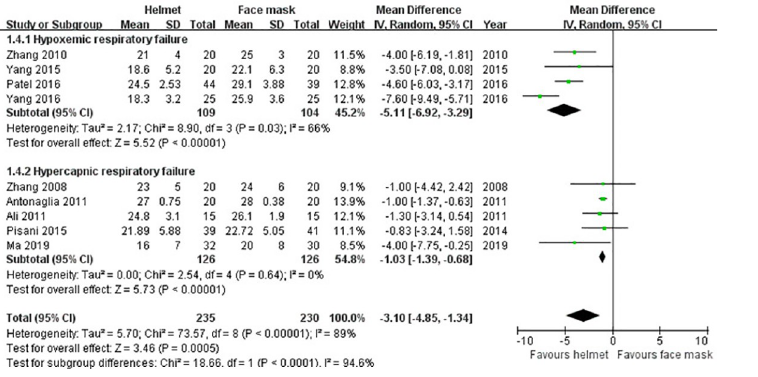
Fig 7. Forest plot of respiratory rate.